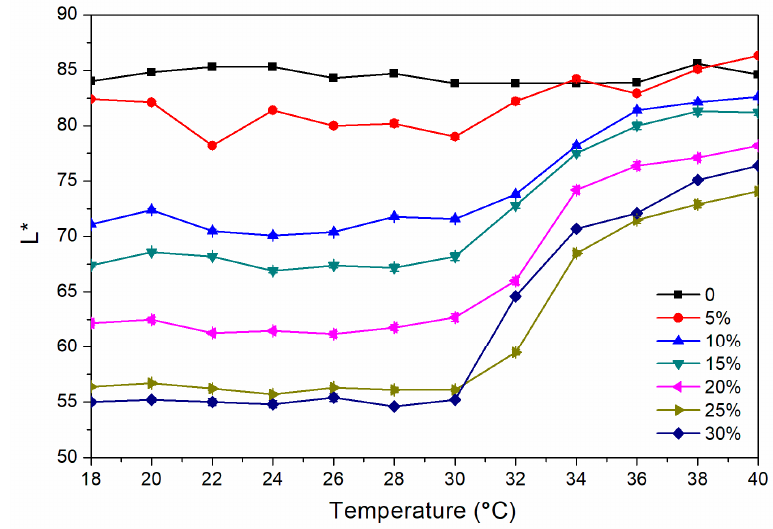
Figure 1. Change of L* value from 18 to 40 ° C.